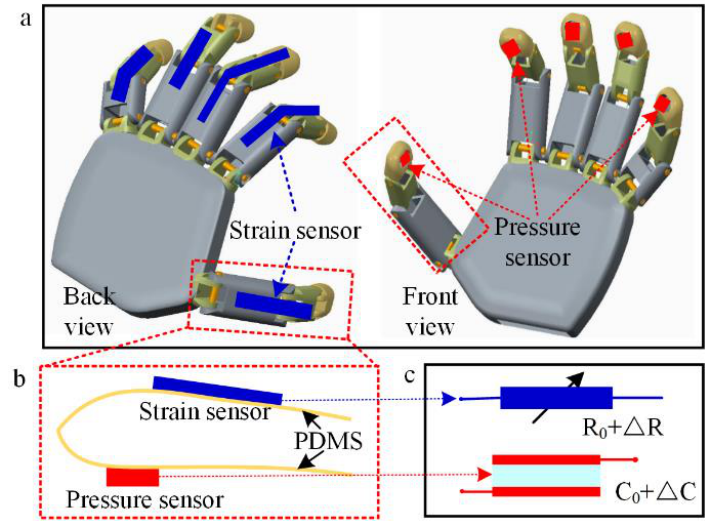
Figure 1. Schematic graph of RES. ( a ) The robot finger integrated with stain and pressure sensors. ( b ) Strain and pressure sensor on the soft substrate. ( c ) Principle of the strain and pressure sensors.